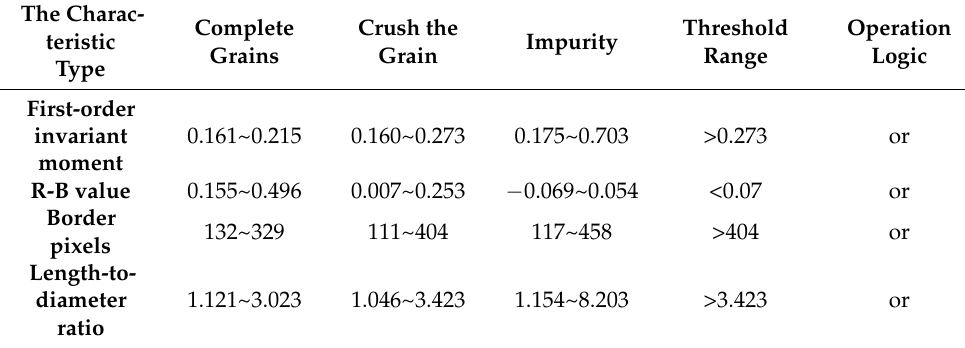
Table 5. Statistics of variation range of corn kernel and impurity characteristics and threshold set- ting.